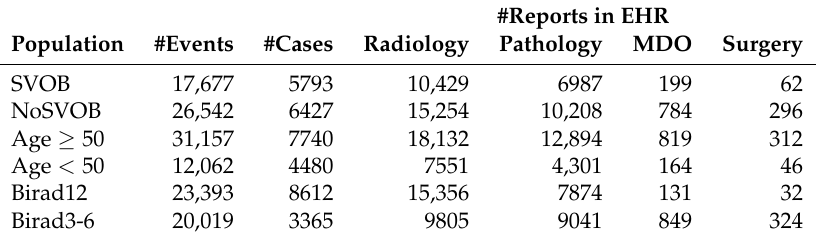
Table 4. Overview of the selected sub-populations with first-level events.